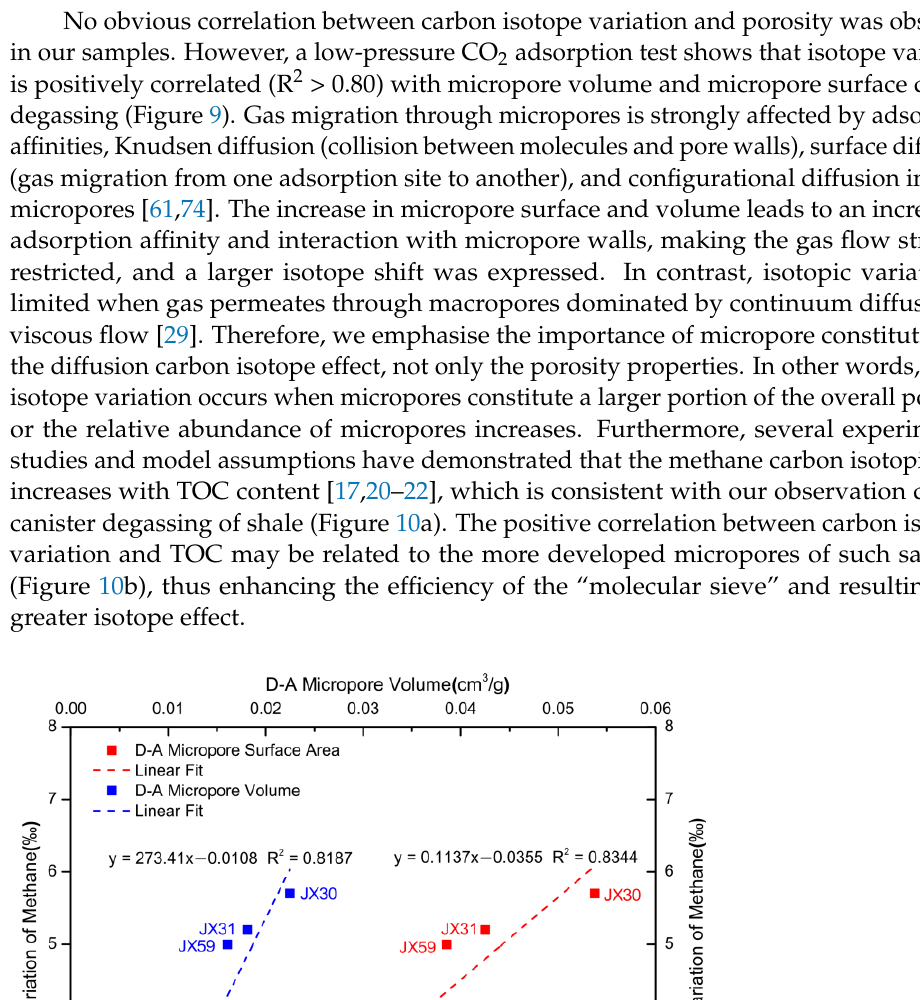
Figure 10. Variation in the values of δ 13 C CH4 , D-A micropore surface area, and micropore volume with TOC during shale gas degassing. ( a ) Variation in the values of δ 13 C CH4 with TOC during shale gas degassing. ( b ) Variation in the values of D-A micropore surface area, and micropore volume with TOC during shale gas degassing. 6. Conclusions Molecular and carbon isotopic variations during degassing of terrestrial shale and the influencing factors were investigated based on time-series sampling. Our results show that gas components and carbon isotopes of shale gas represent instantaneous values and vary constantly during the canister degassing experiment. The methane content first in- creased and then decreased, and the concentrations of carbon dioxide and nitrogen peaked in the early degassing stage, while heavier hydrocarbons showed a depletion in the early degassing stage and gradually increased over time. In comparison, shale gas generated from humic source rocks contain more non-hydrocarbon and less heavy hydro- carbon components than that generated from sapropelic source rocks with similar ma- turity. The isotope shift of methane varied from 2.2‰ to 5.7‰, and the minimum isotope variation was found in a high-permeability sample. For all samples, the degree of carbon isotope variation was positively correlated with microscope volume and microscope sur- face, indicating that micropores contribute significantly to the kinetic isotope effect. This is also the case for larger isotopic variation accompanied by a higher TOC values. Unlike